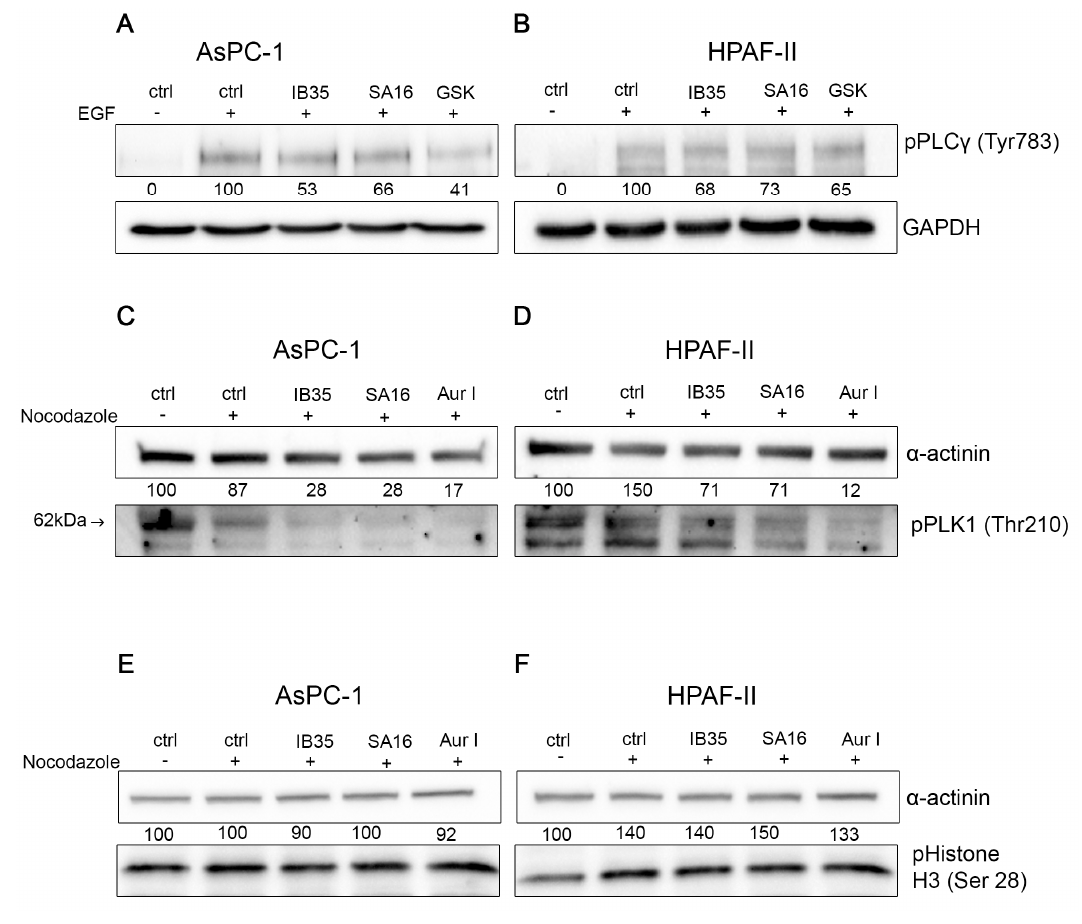
Figure 5. ( A , B ) E ff ect of SA16 and IB35 on PLC γ 1 Tyr783 phosphorylation. AsPC-1 ( A ) and HPAF-II ( B ) were serum starved for 24 h, treated for 30 min with IB35, SA16 (both 10 µ M) or GSK2334470 (5 µ M) and stimulated for 10 min with 25 ng / mL of EGF to induce activation of PLC γ 1. Lysates were then assessed by Western blotting using the indicated antibodies. Representative blots of at least three independent experiments are shown. The percentage of phosphorylated PLC γ 1 is calculated by normalization to the loading control GAPDH. ( C , D ) E ff ect of SA16 and IB35 on the activation of PLK1 at Thr210. AsPC-1 ( C ) and HPAF-II ( D ) were treated with nocodazole (200 ng / mL) 24 h, treated for 1 h with IB35, SA16 (both 10 µ M), or Aurora A Inhibitor (5 µ M). The percentage of phosphorylated PLK1 is calculated by normalization to the loading control α -actinin. ( E , F ) E ff ect of SA16 and IB35 on the phosphorylation of Histone H3 at the Ser28 residue. AsPC-1 ( E ) and HPAF-II ( F ) were treated with nocodazole 200 ng / mL 24 h, treated for 1 h with IB35, SA16 (both 10 µ M), or Aurora A Inhibitor (5 µ M). The percentage of phosphorylated Histone H3 is calculated by normalization to the loading control α